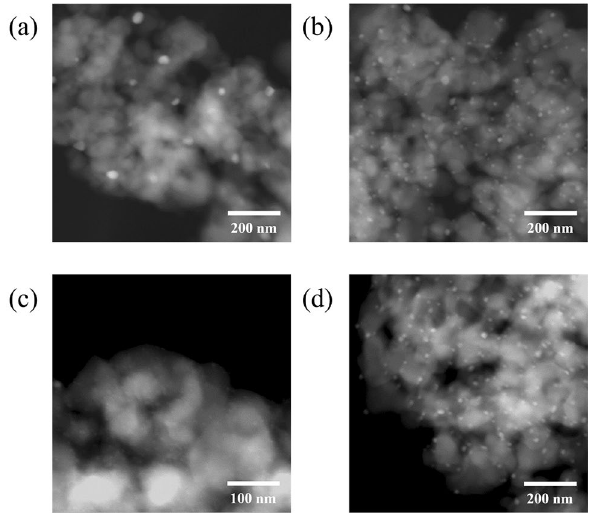
Fig. 7 Scanning electron microscopy images of the synthesized